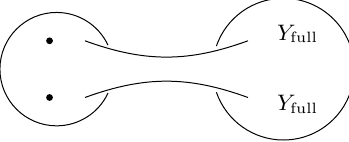
Figure 7 . S-dual descriptions for L ( n ) (left) and T ( n ) (right). In the left quiver, an SU(2) gauge 0 ;n; 0 0 ;n; 0 group is coupled to a fundamental hypermultiplet and an isolated SCFT called R 0 ;n . In the right quiver, an SU(2) gauge group is coupled to AD 3 (playing the role of the hypermultiplet) and an exotic (cid:12)xture we call R 2 ; AD (this latter theory is a type III theory in the nomenclature of [3]). 0 ;n